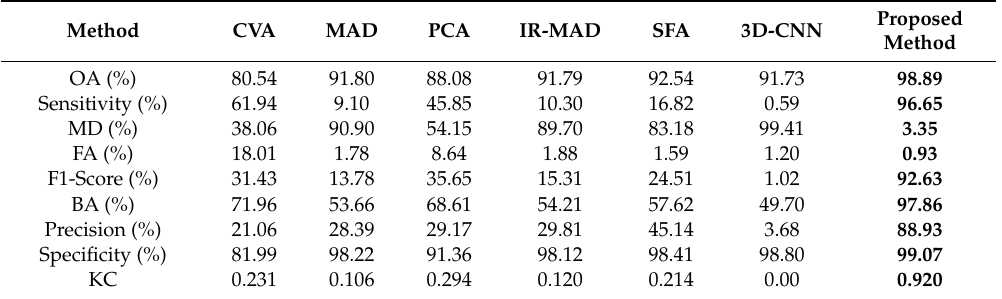
Table 8. The accuracy of different change detection methods for the Multispectral-Abudhabi dataset (the best performance for each method appears in bold).